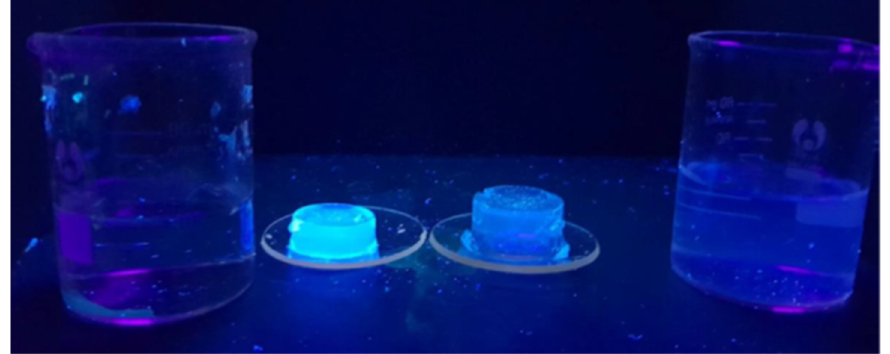
Figure 5. Two polyacrylamide pellets with 60 μ M 4 irradiated with 365 nm light after 1 day of exposure to aqueous solutions. (Left) pellet of 4 after exposure to deionised water and (right) after exposure to aqueous 1 M NaCl solution. Na + -driven on–off (NOT) logic is observed. The supernatant in the beaker (right) emits blue emission due to leaching of 4 and incomplete saturation of the benzocrown receptor.